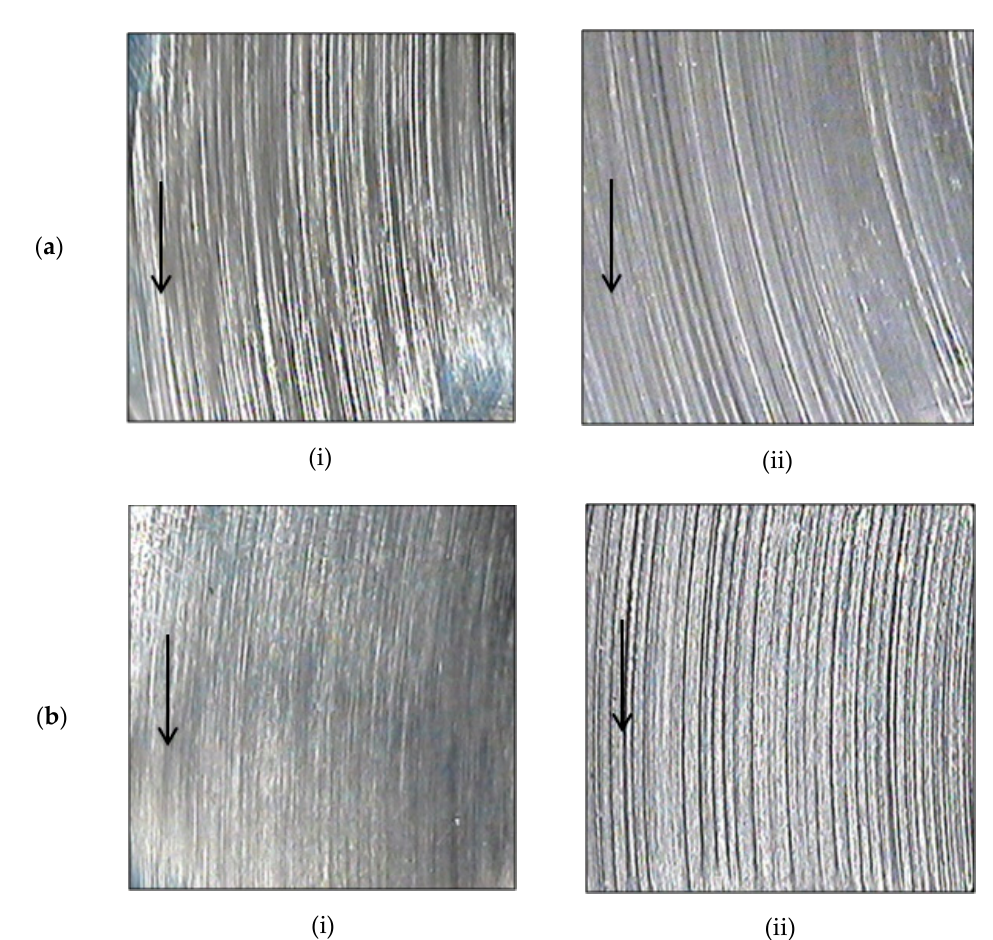
Figure 5. Optical micrograph of transfer film on steel counterface that slide against ( a ) EP/GF and ( b ) EP/BF composites at (i) 0. 23 MPa.m/s and (ii) 0. 93 MPa.m/s PV factor.